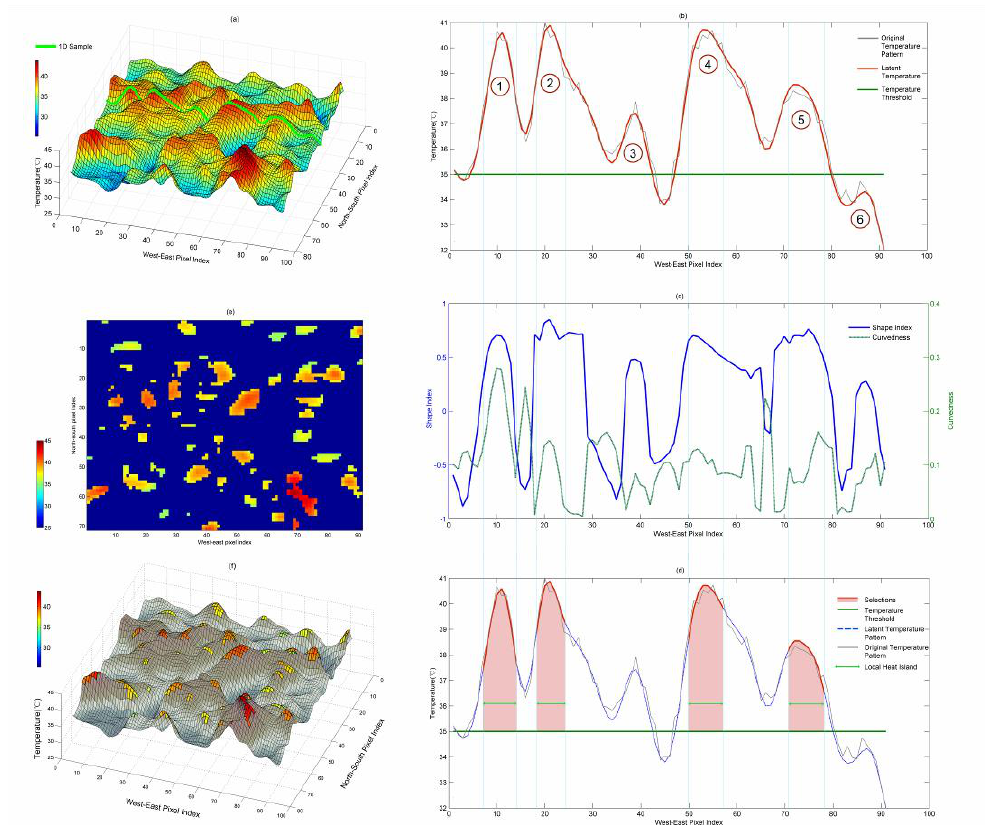
Figure 7: The LSUHIs meet the selection criteria. (a) Location of the column pixels for 1D illustration. (b) The profiles of the 1D LST as well as the temperature threshold. (c) The MSSI and the curvedness of the 1D LST. (d) The selections of LSUHIs in 1D. (e) The selections in 2D. And (f) Selections superimposed on the original latent